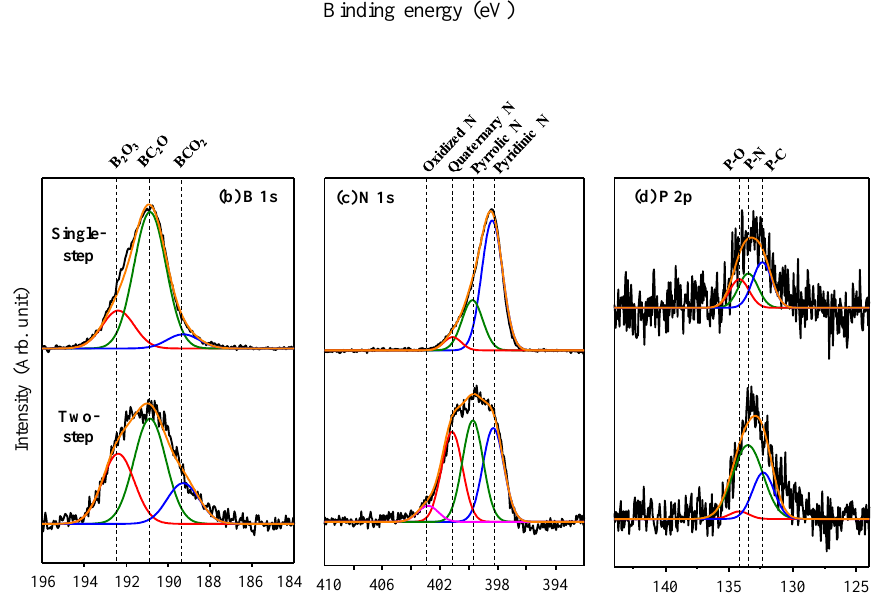
Figure 2. ( a ) Wide scan XPS spectra of BRGO, NPRGO, NPBRGO (single-step) and NPBRGO (two-step) and narrow scan ( b ) B 1s, ( c ) N 1s and ( d ) P 2p XPS spectra of NPBRGO (single-step) and NPBRGO (two-step). Note that B 1s and P 2s peaks are exactly overlapped and two small peaks owing to the B atoms were clearly observed at around 140 and 100 eV. The structural integrity of the doped RGO was evaluated by the Raman spectra using 532 nm laser line (Figure 3a) [34]. There are two major peaks at 1340 cm −1 (defect-induced mode, D-band) and 1580 cm −1 ( E 2g2 , G-band) for ternary doped RGOs. To evaluate the de- gree of disorder caused by heteroatom doping, FWHM (full width at half maximum), the R value ( I D /I G , the integrated intensity of the D-band is divided by the integrated intensity